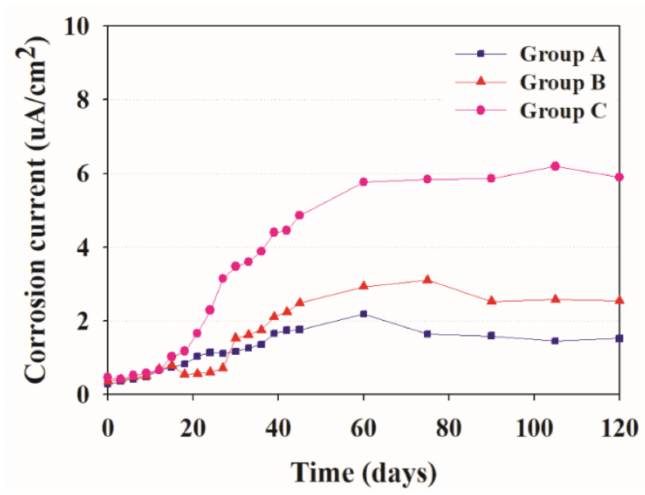
Figure 4. Corrosion current vs.